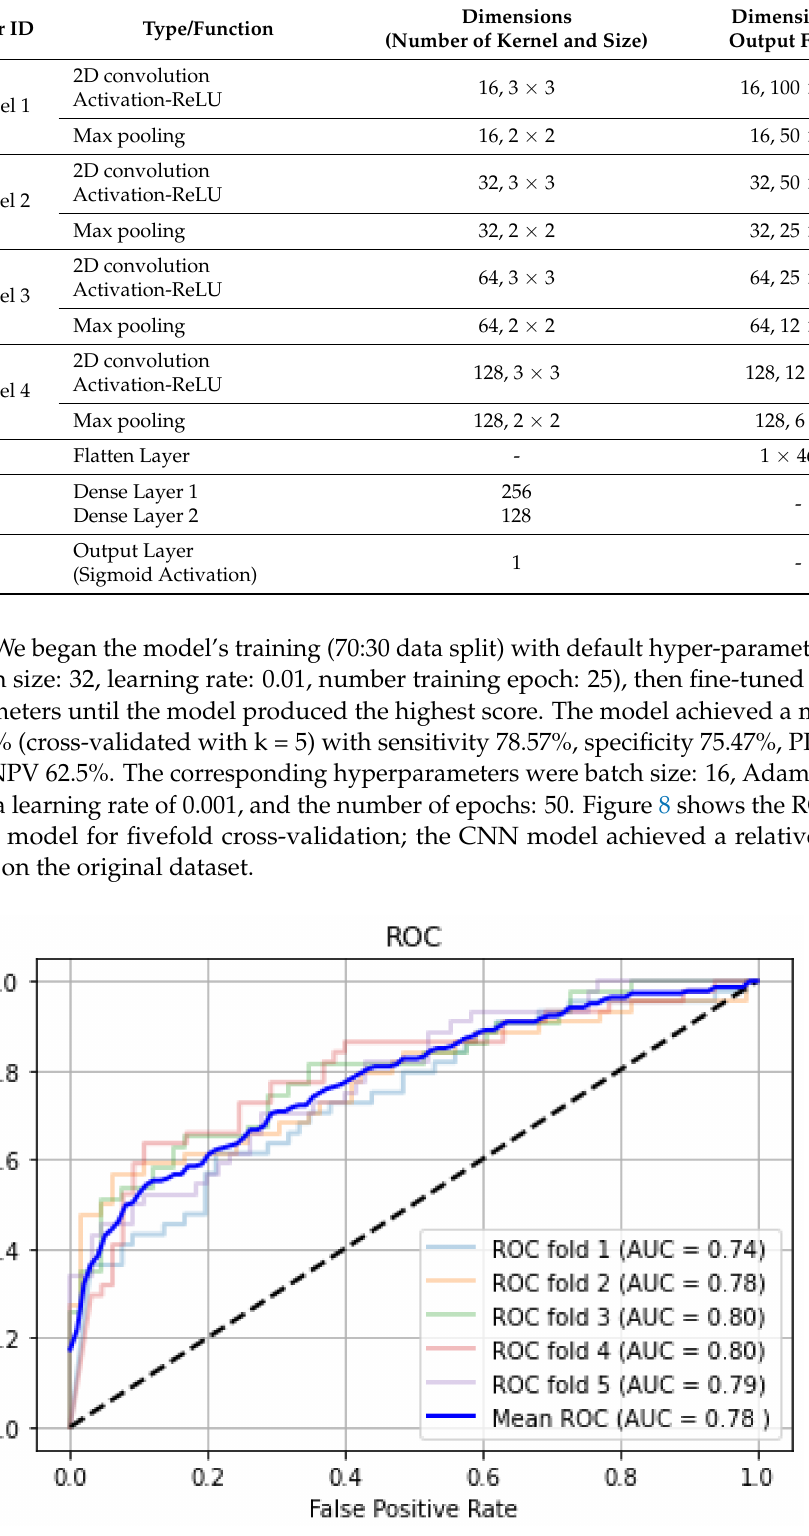
Figure 8. Cross-validated ROC on the original